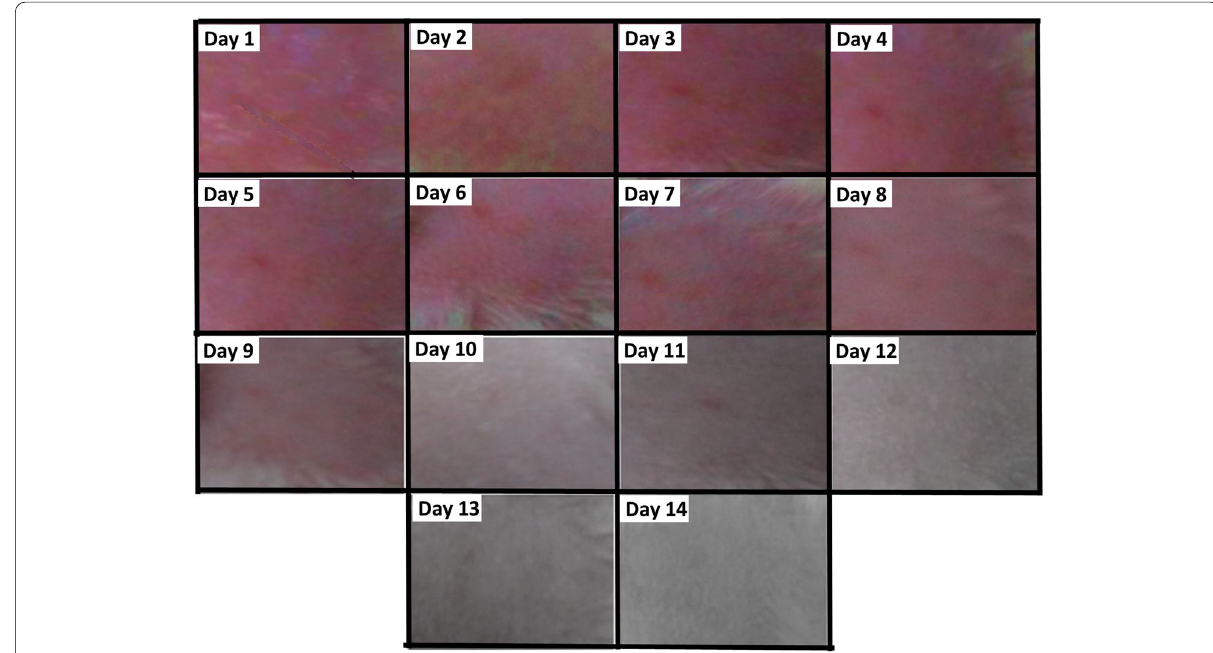
Fig. 3 Draize test of the optimized niosomal batch for checking any signs of irritation on the skin